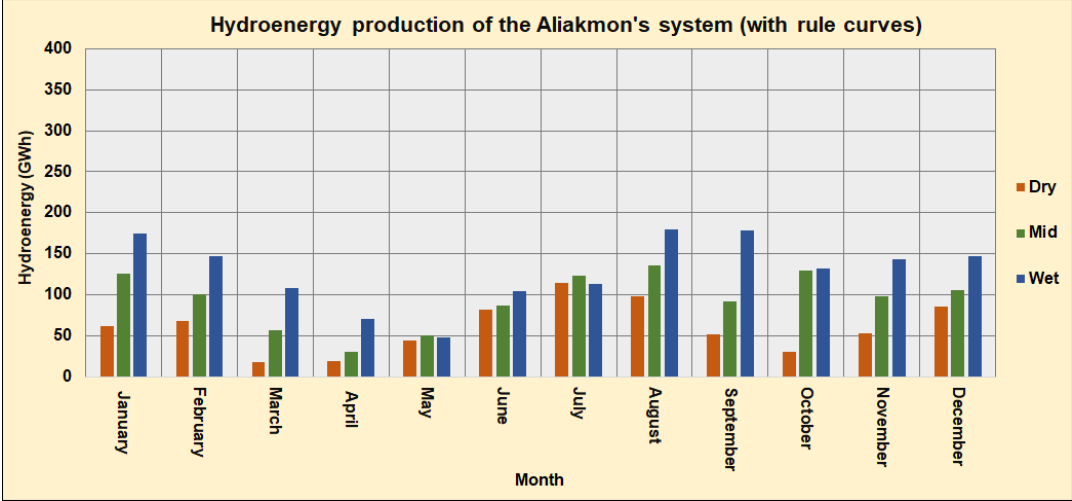
Figure 15. Monthly hydro energy production of the Aliakmon’s system, applying the institutional operating rule curves.